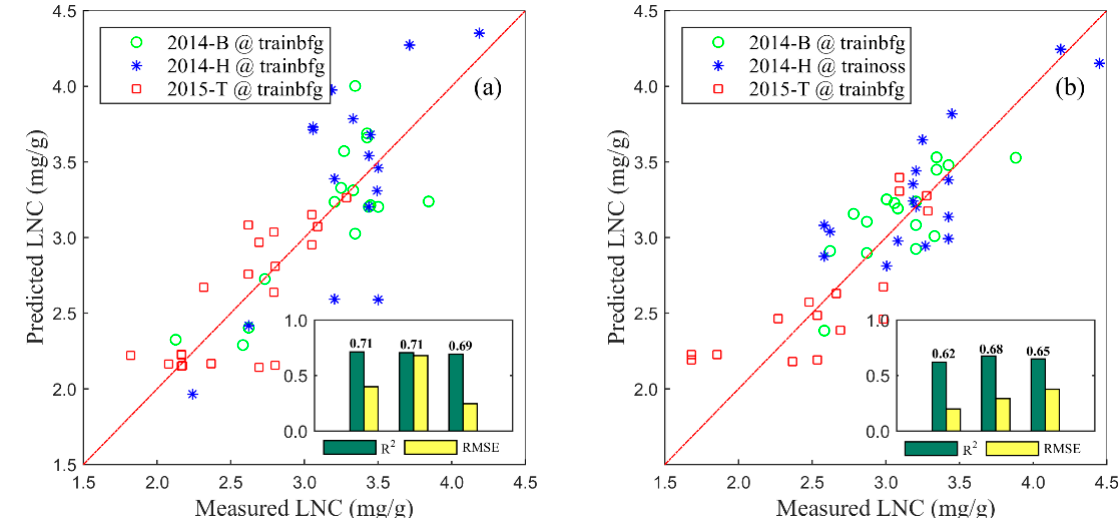
Figure 5. Estimation results of LNC using ANN with different training functions in 2015. Subgraph ( a ) shows the predicted versus measured LNC with FW-based NCI H-F in four prior bands; ( b ) is that using GSIs. Histograms show the corresponding R 2 and RMSE values for 2014-B, 2014-H and 2015-T respectively.